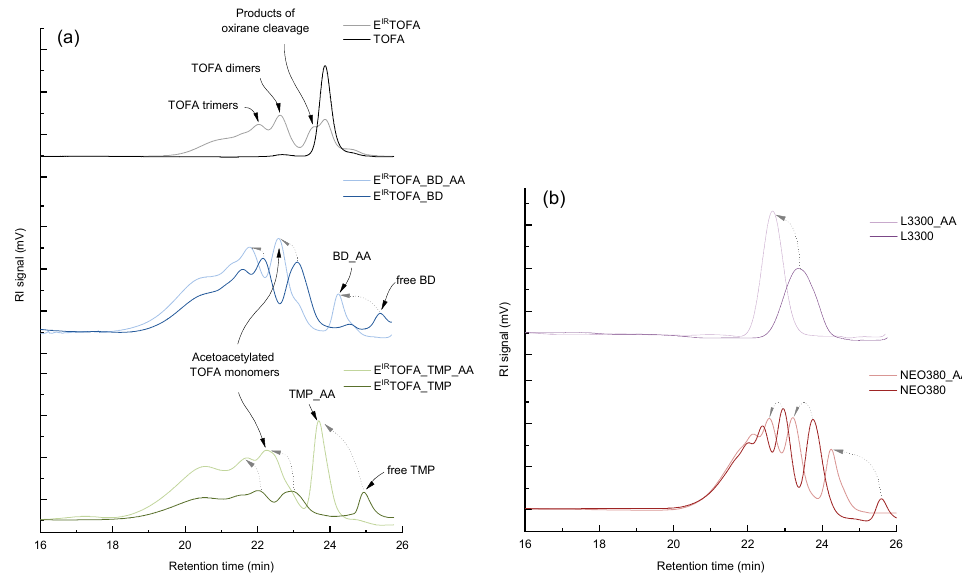
Figure 5. GPC/SEC chromatograms of TOFA, E IR TOFA, synthesized polyols, commercial polyols and their corresponding acetoacetate: ( a ) based on tall oils; ( b ) based on commercial polyols.